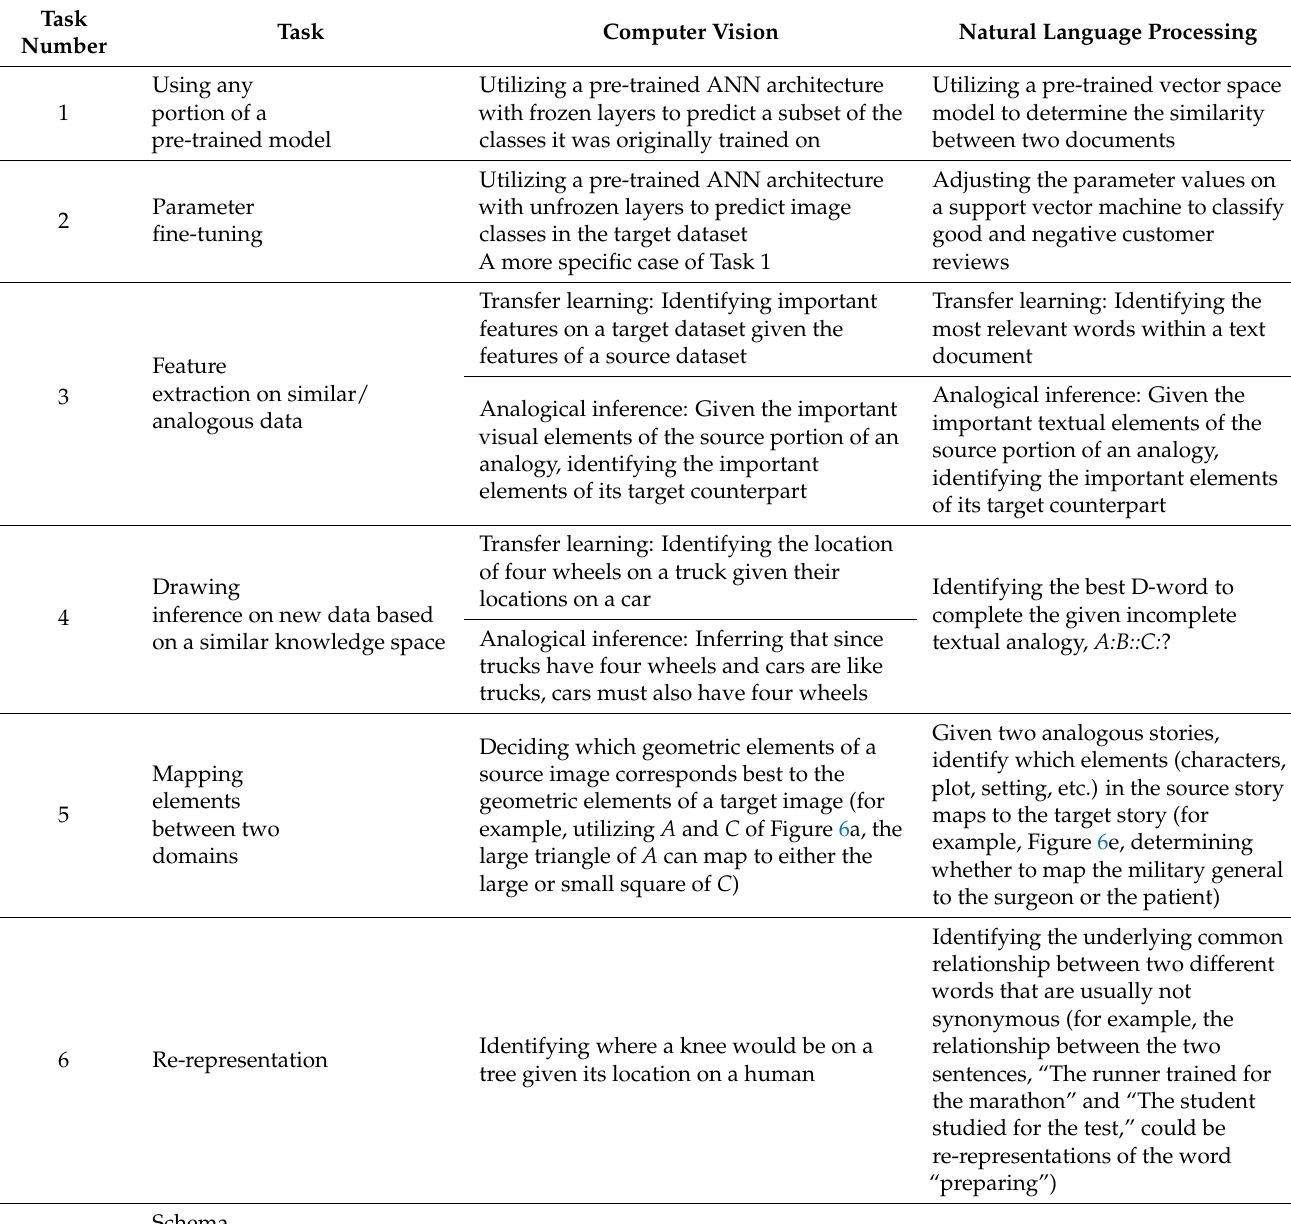
Table 5. Specific examples of transfer learning and analogical inference task(s) within computer vision and natural language